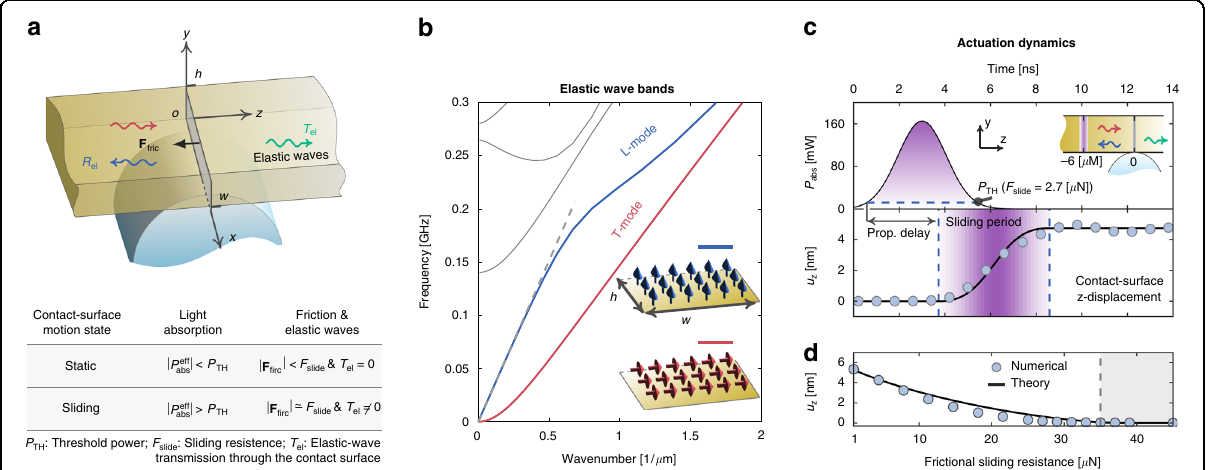
Fig. 1 Principle of opto-thermo-mechanical actuation overcoming µN-scale friction force at micro-scales. a Driving locomotion of a rectangular plate on a frictional surface through excitations of elastic waves by pulsed optical absorption. The contact surface is a line-shaped region rendered by the surface curvature of the substrate. Table: relationships between motion states of the plate, (instantaneous) effective absorbed light power, friction force and elastic waves. b Band structure of elastic waveguide modes in a gold plate (width, w = 4 µm; height, h = 60nm). Insets: modal pro fi les of fundamental longitudinal ( L )- and transverse ( T )-like modes at static frequency (arrows specify directions of elastic oscillations). c Sliding displacement of the contact surface of the gold plate (same as in b ; lower panel) in the z -direction driven by a nanosecond optical pulse (upper panel) with frictional sliding resistance F slide = 2.7 µN. The absorbed optical power distributes uniformly in the x-y plane, has a Gaussian width of 1µm in the z -direction and localizes on the left side of the contact surface (sketched in the inset of the upper panel). d Stabilized sliding displacement as a function of sliding resistance, F slide . In ( c , d ), the numerical results are obtained with the COMSOL Multiphysics (circles) and agree with the theoretical predictions [solid lines; computed with Eq. (2.18) in the Supplementary Material]. The elastic attenuation is